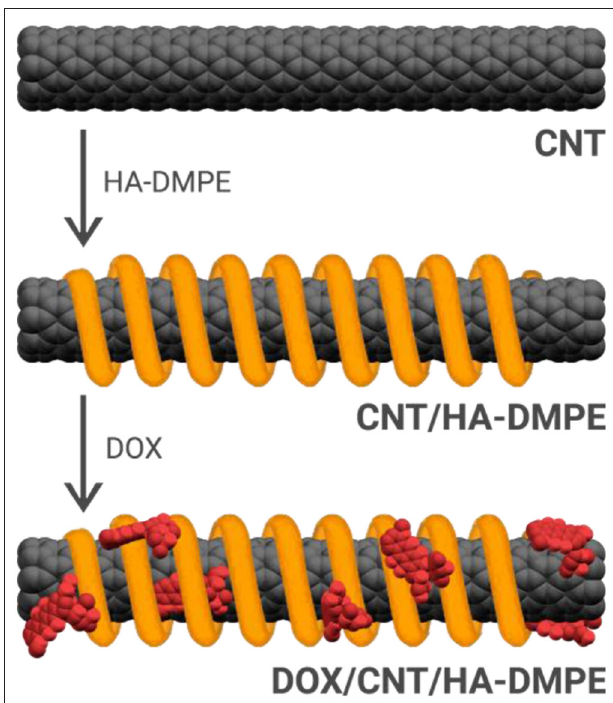
FIGURE 2 | The non-covalent approach for the functionalization of CNTs with the HA-DMPE conjugate (orange helix) and DOX (red) to make a DOX/CNT/HA-DMPE